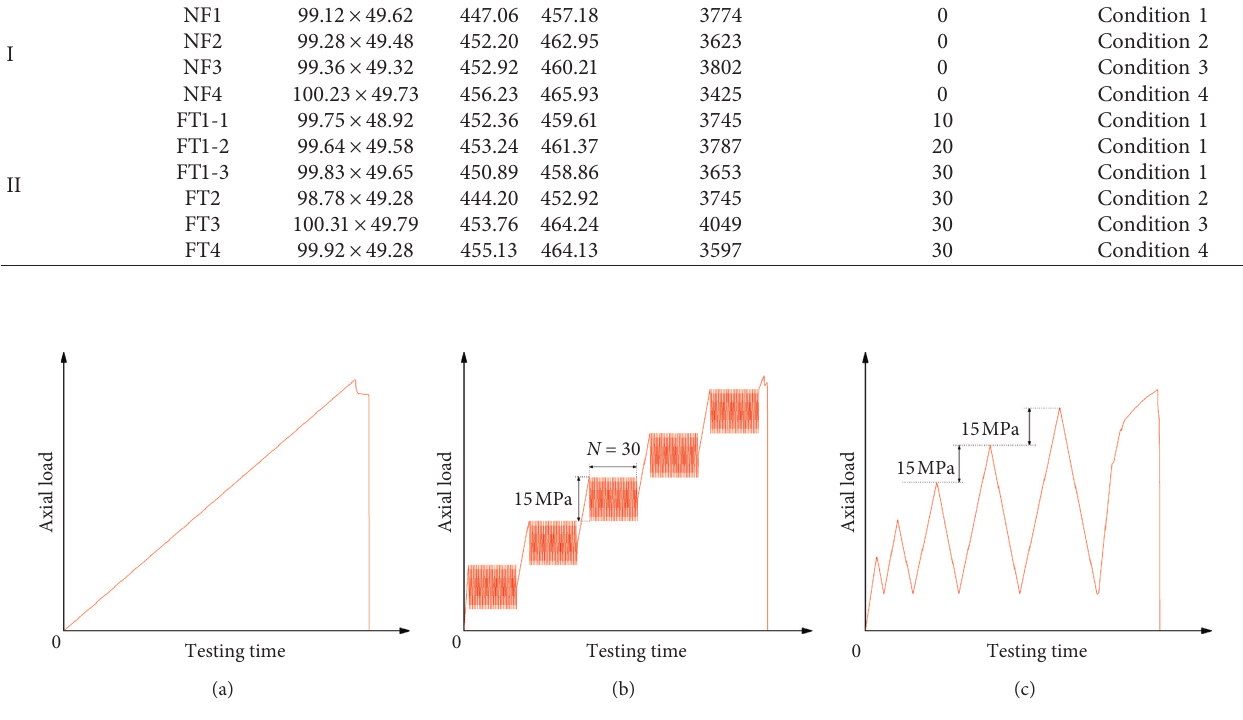
Figure 3: Three different stress paths: (a) conventional uniaxial compression tests; (b) increasing amplitude stress-cycling tests; (c) equal incremental cyclic loading